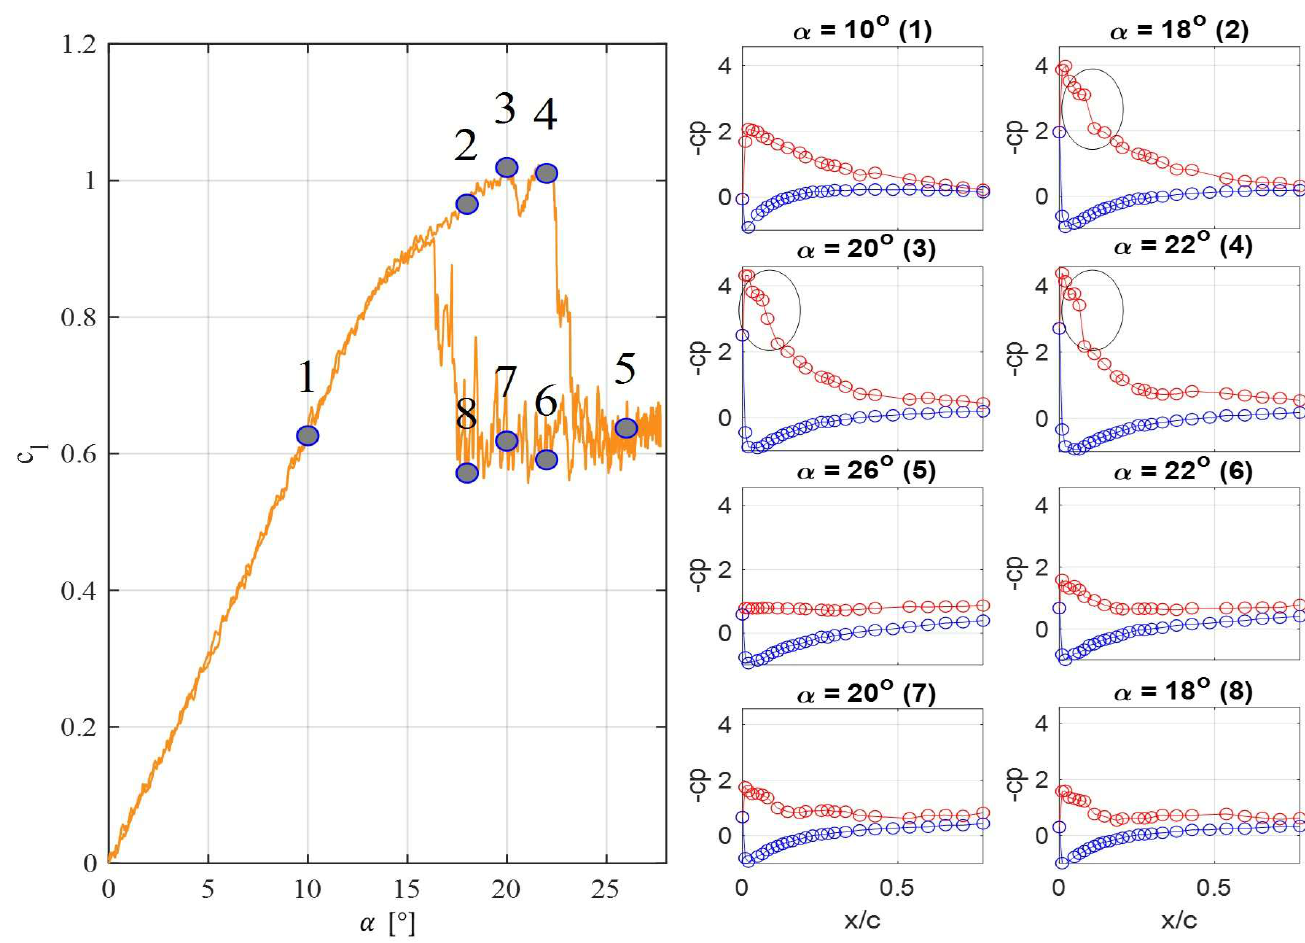
Figure 9. Chronology of events in the quasi-static lift curve along with the surface pressure measurements. Pitch-up (1 through 5) followed by pitch-down (5 through 8).